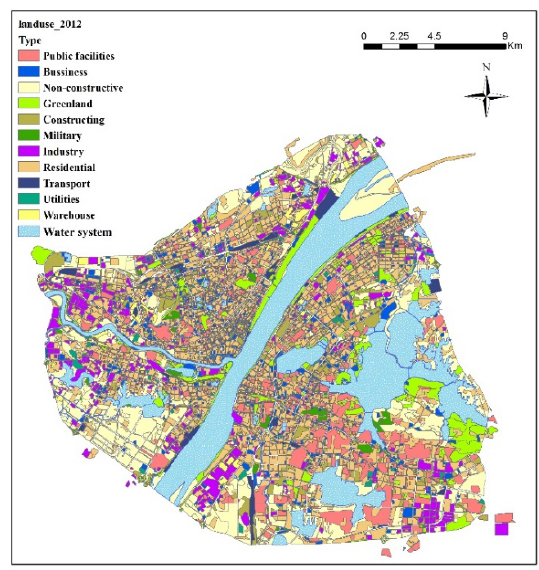
Figure 1. The land use data of Wuhan.